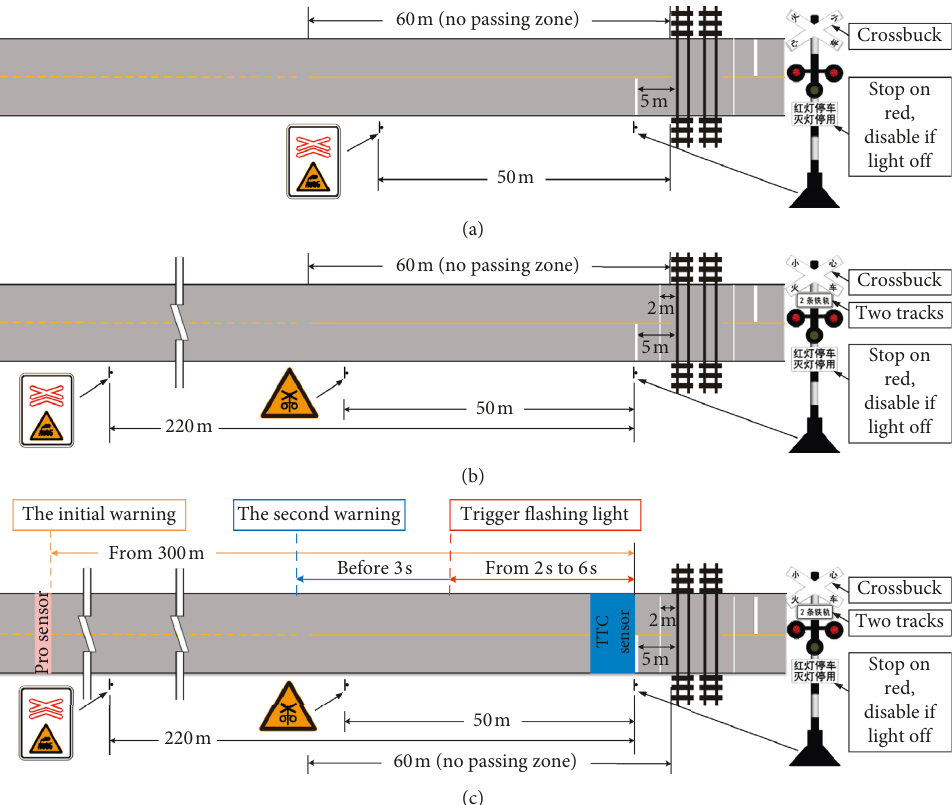
Figure 4: Standard and proposed design of signs and pavement markings for grade crossing of China. (a) Standard design of signs and pavement markings for grade crossing of China; (b) proposed design of signs and pavement markings for grade crossing; (c) diagram of the grade crossing with